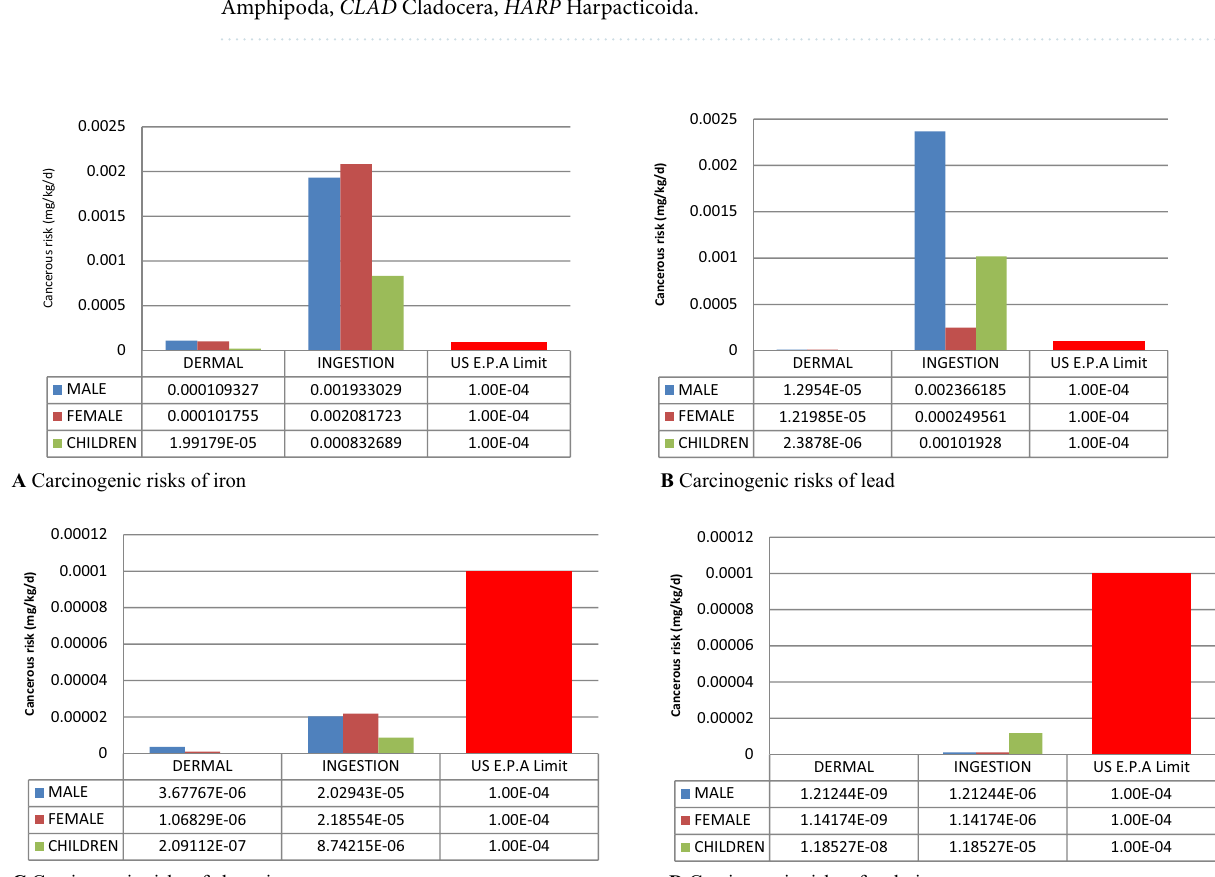
Table 6. Correlation between abiotic factors and zooplankton species of Egbokodo River. Emboldened values are ≥ 0.5, hence significant at p < 0.05. OG oil and grease, CALA Calanoida, CYCL Cylcopoida, AMPH Amphipoda, CLAD Cladocera, HARP Harpacticoida.